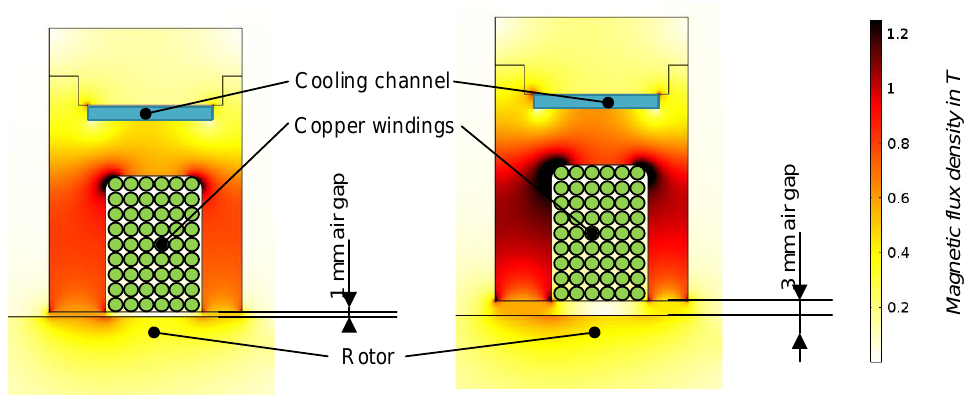
Figure 11. Design and magnetic flux density distribution in the electromagnet at different air gaps for a weight compensation of 1350 N. Simulation conducted with Comsol Multiphysics 5.6.